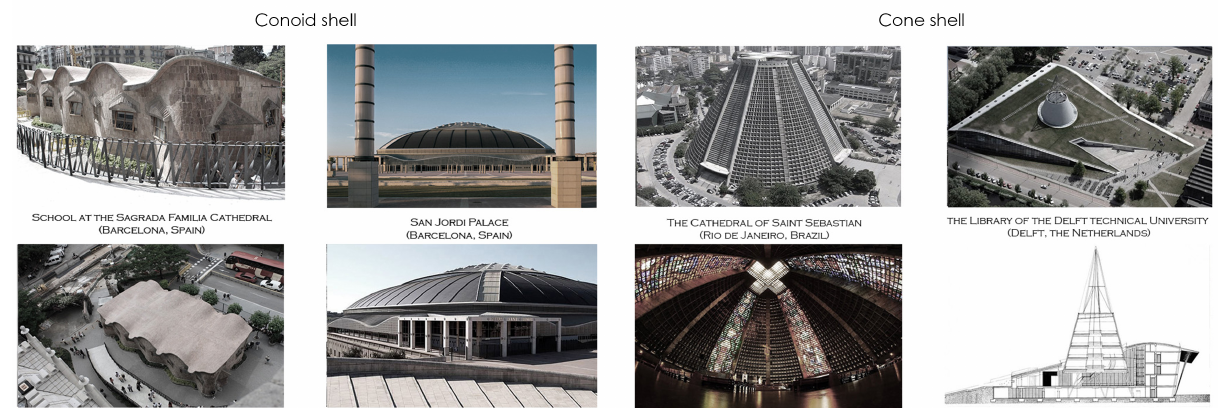
Figure 3: The using of conoid and cone shells in the buildings